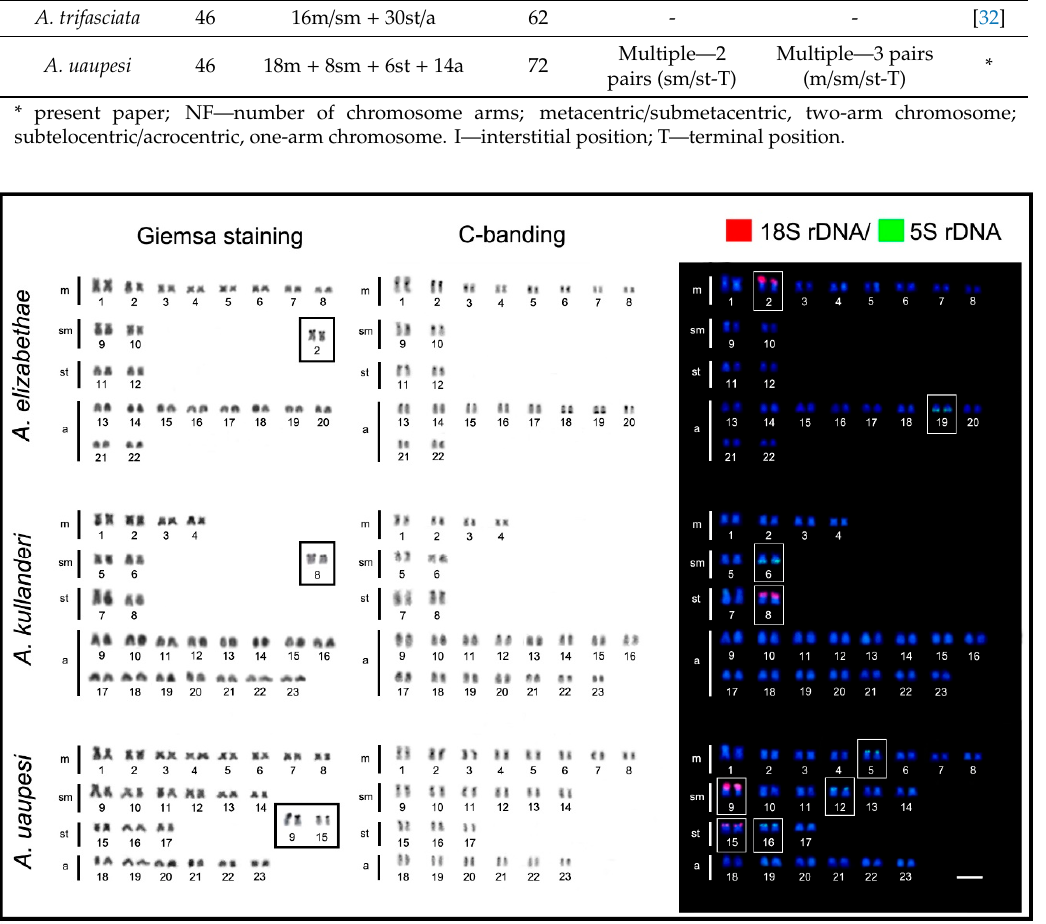
Figure 3. Karyotypes of Apistogramma elizabethae , Apistogramma kullanderi , and Apistogramma uaupesi arranged as described in Figure 1.